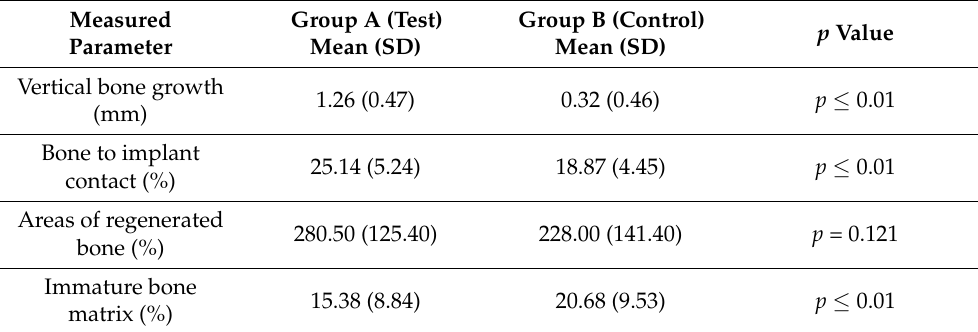
Table 2. Table of descriptive statistics (mean and SD) and statistical significance of the differences between the vertical bone growths (mm), percentages of the bone to implant contact (%), areas of regenerated bone (mm 2 ) and immature bone matrix (%) of the